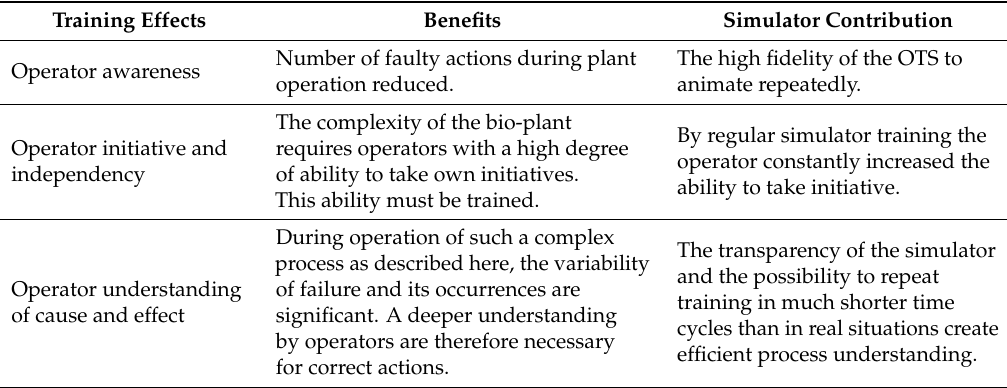
Figure 9. On-line signals from the start-up procedure (shown here for 13 h). The graphs show changes of volume and temperature in the LF and SF1 tanks as well as automatically controlled adjustment of in- and outflow of the LF tank. Symbols below from the left: (1) add or remove a signal; (2) change time range; (3) change scale for signal; and (4) export/print results. Numbers indicate the procedural step according to the provided SOP (Table S2). Table 2. Training effects and benefits for plant